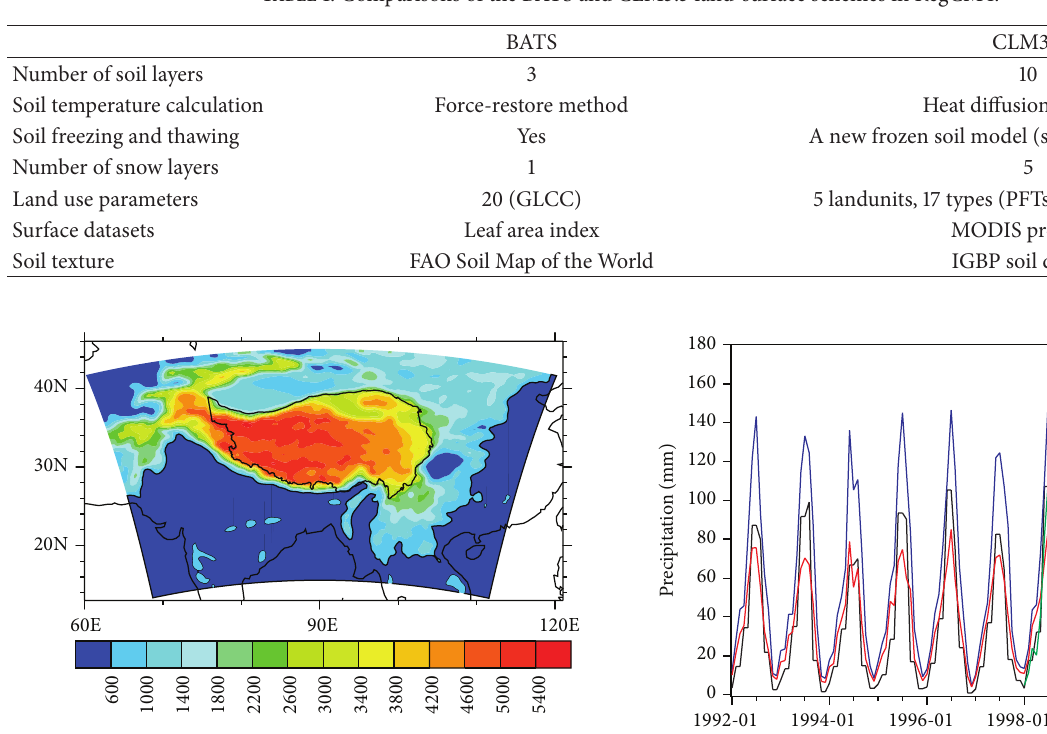
Figure 1: Model domain and analysis region of this experiment (unit: m). Table 2: Model configuration used in this study. Figure 2: Monthly variations in the observed and simulated